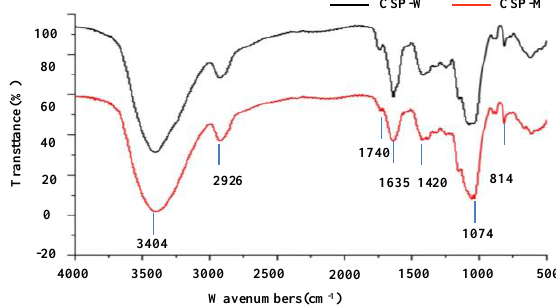
Figure 4. FT-IR spectra of CSP-W and CSP-M. CSP-W , Cassia seed polysaccharides extracted by hot water extraction; CSP-M , Cassia seed polysaccharides extracted by microwave-assisted